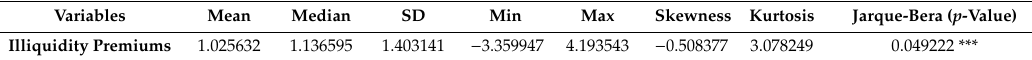
Table 1. Descriptive statistics for dependent variable.